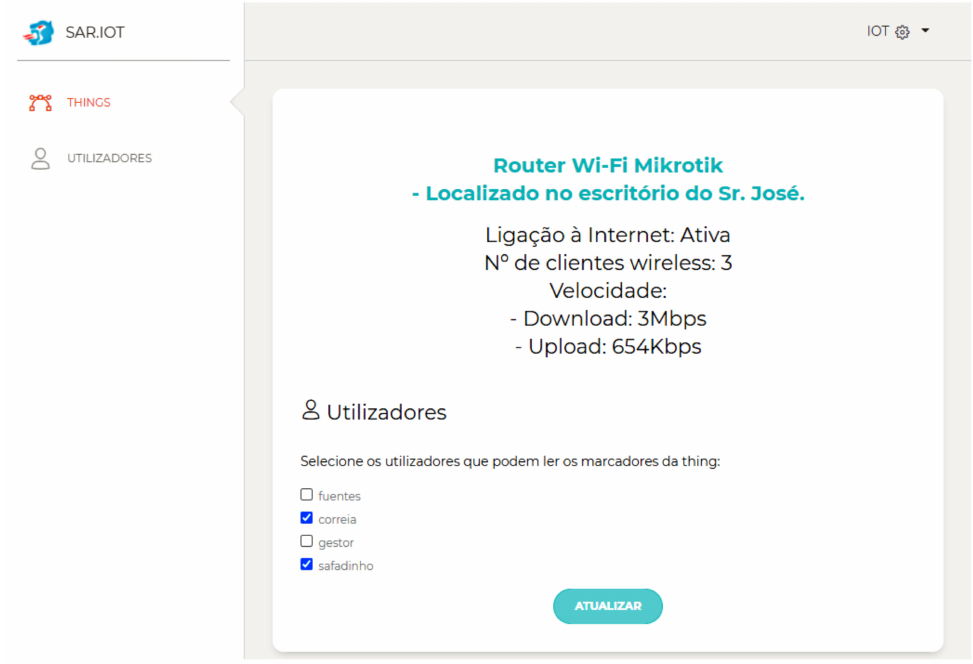
Figure 17. Association between an IoT device and